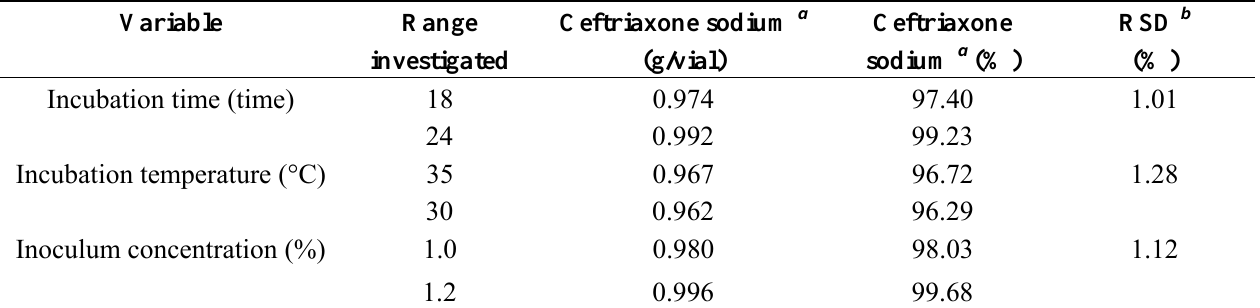
Table 3. Parameters assessing the robustness of the method